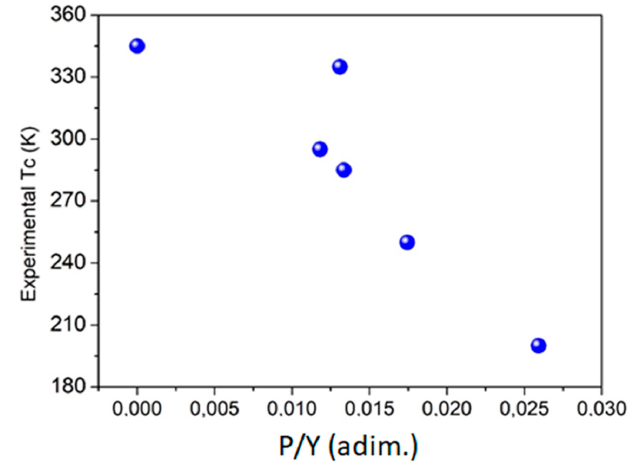
Figure 1. Experimental critical temperature values of La 2/3 Sr 1/3 MnO 3 films at different deformations [23].